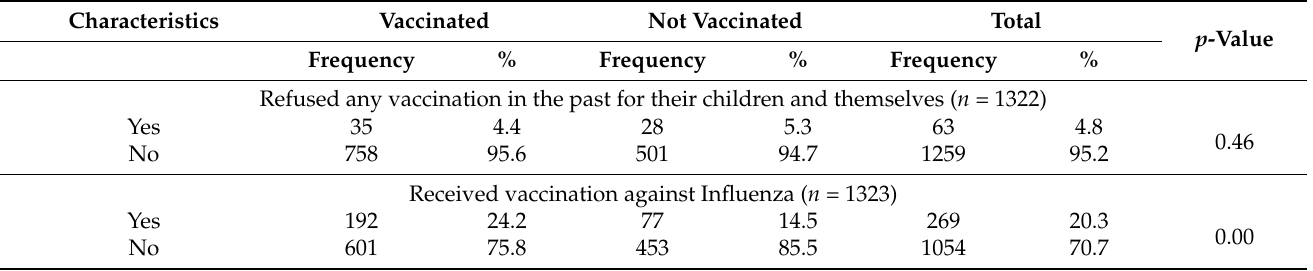
Table 4. Vaccination history of respondents.